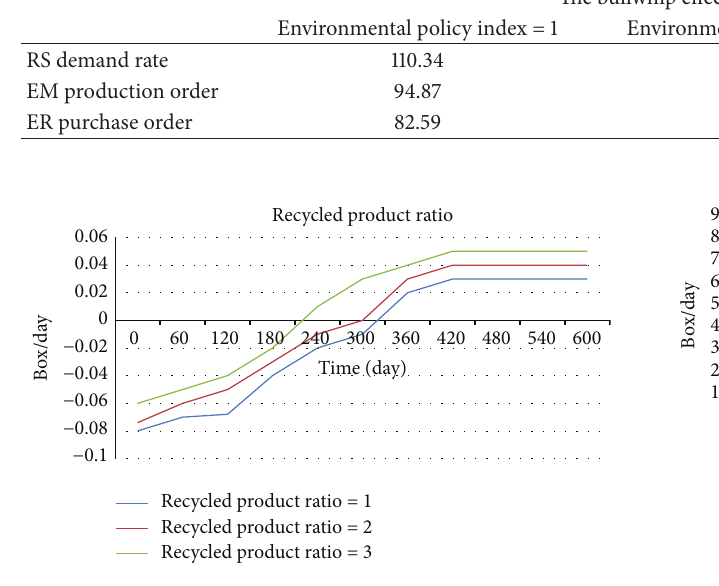
Figure 3: The third-party recycler’s recycling ratio under different environmental policy index.